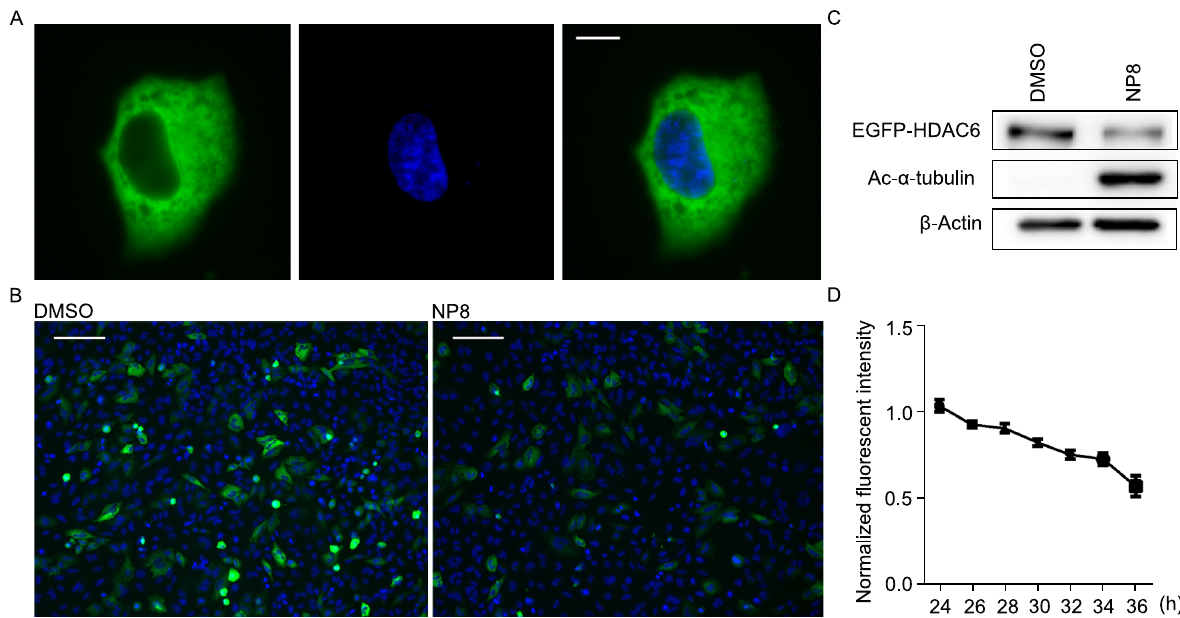
Figure 2. Visualization of NP8-induced degradation . (A) The EGFP-HDAC6 (green) was localized in the cytoplasm of HeLa cells. Scale bar: 10 µm. (B) NP8 treatment caused reduced fl uorescence signal within 48 h. Nuclei were labeled by Hoechst 33342 (blue). Scale bar: 50 µm. (C) Con fi rmation of EGFP-HDAC6 degradation in (B) by immunoblotting. (D) Relative mean fl uorescence intensity of representative single cells was monitored via confocal microscope from 24 h to 36 h post 5 µmol/L NP8